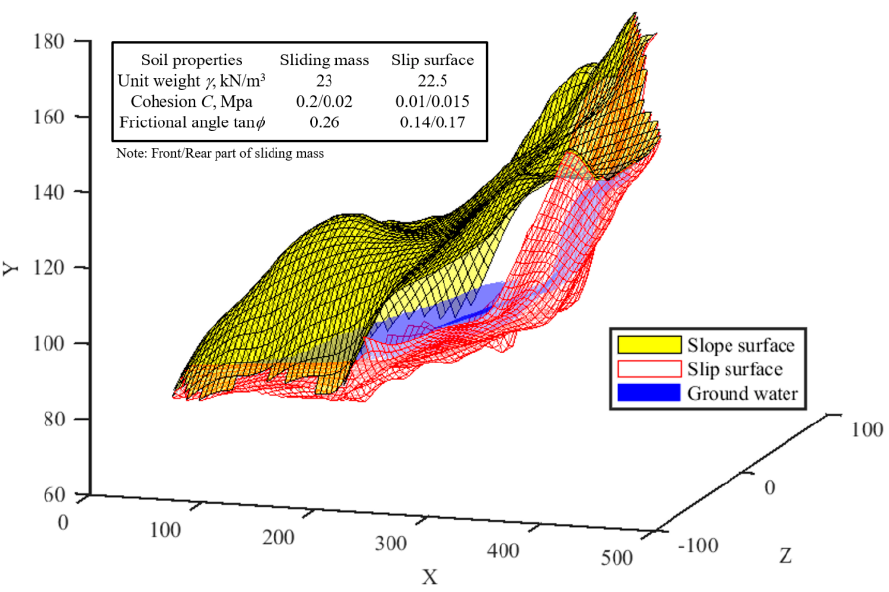
Figure 4. Meshing grid of the sliding mass for the practical slope.